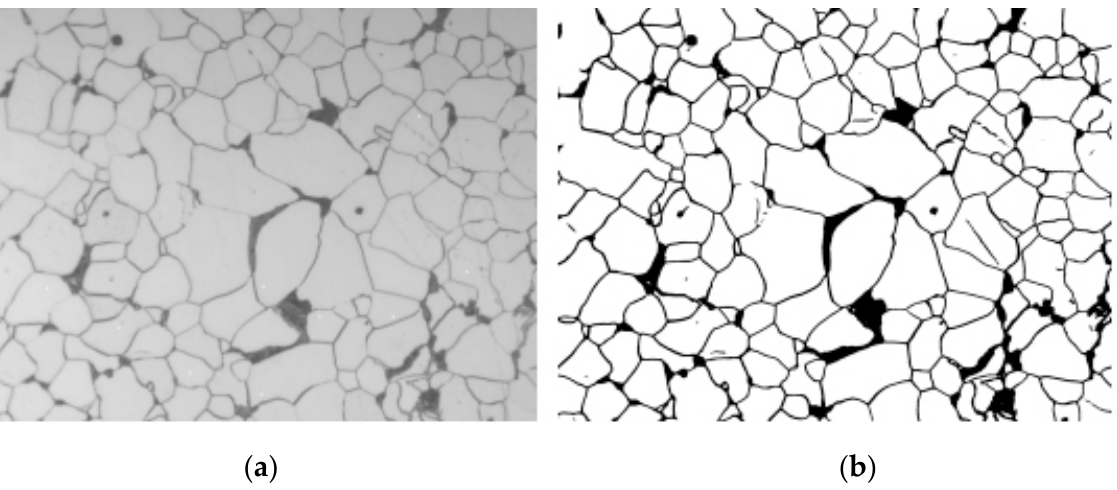
Figure 8. Grain-boundary contours identified by the model. Original image ( a ) and image of model predictions ( b ).